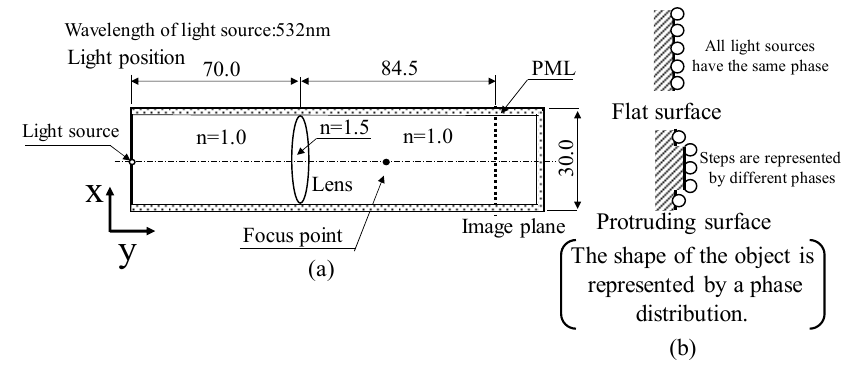
Figure 2. Computer simulation model. ( a ) Optical system. ( b ) Measured object.